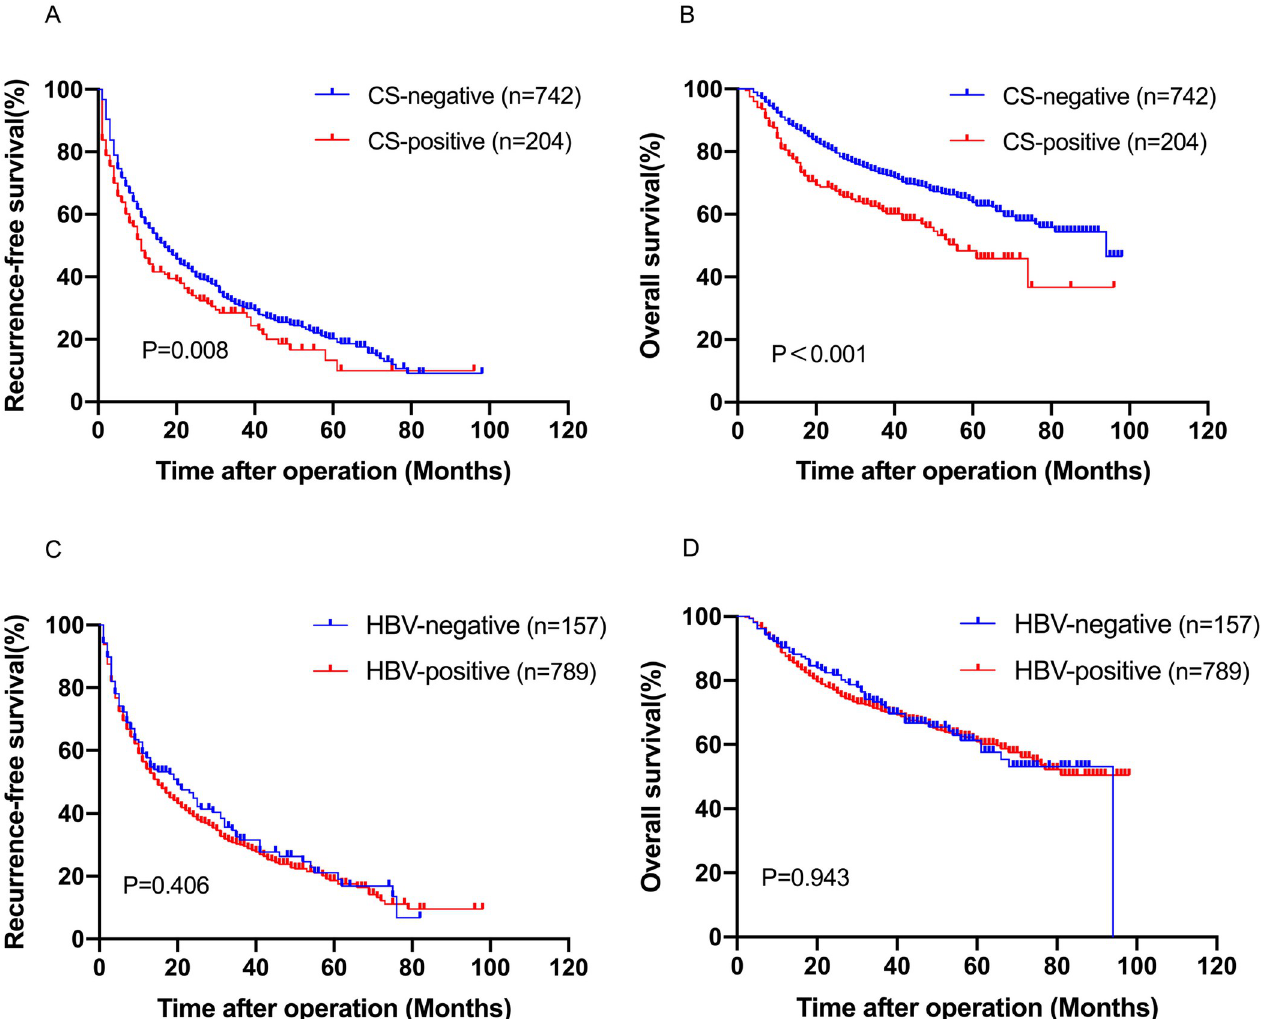
Fig 2. The influence of CS and HBV on the prognosis of patients with HCC after hepatectomy. (A), CS for recurrence-free survival; (B), CS for overall survival; (C), HBV for recurrence-free survival; (D), HBV for overall survival.